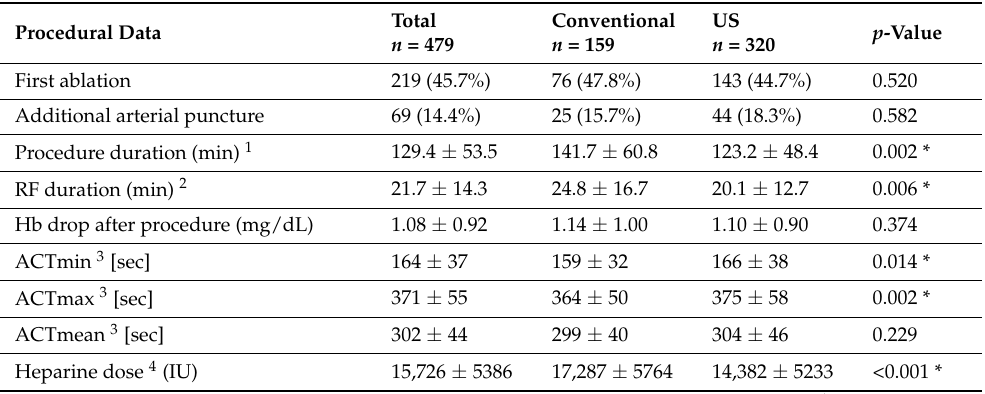
Table 4. Procedural